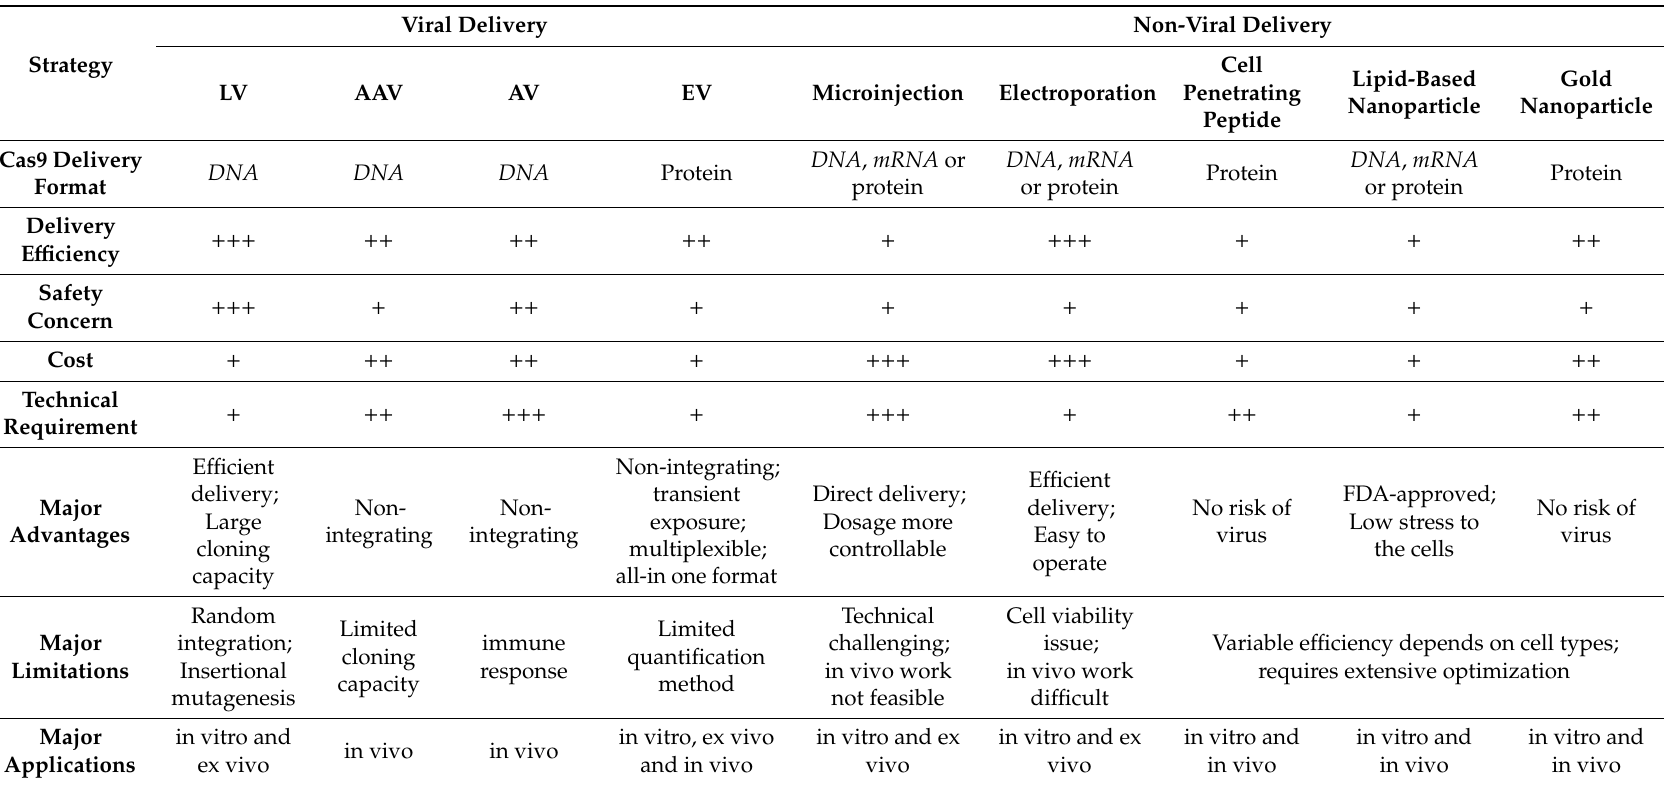
Table 1. Comparison of common clustered regularly interspaced short palindromic repeats (CRISPR) / Cas9 delivery